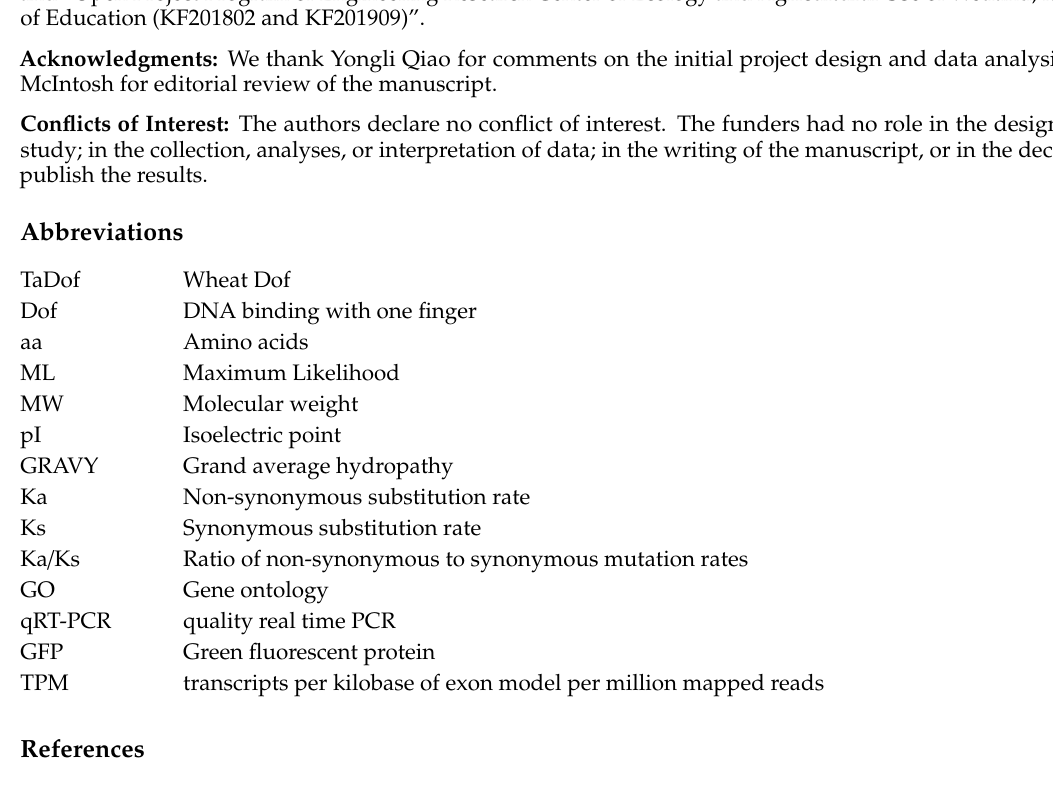
Table S8: Functional annotation of wheat Dof genes, Table S9: TaDof gene expression levels represented by TPM values, Table S10: Wheat miRNAs targeting TaDofs, Table S11: The cis-elements in upstream sequences of TaDof genes, Table S12: Function prediction of TaDofs by BLASTp searching, Table S13: BLASTp search results, File S1: Sequences of Dof genes and coding proteins used in this research, File S2: Sequences of Dof genes with experimentally supported